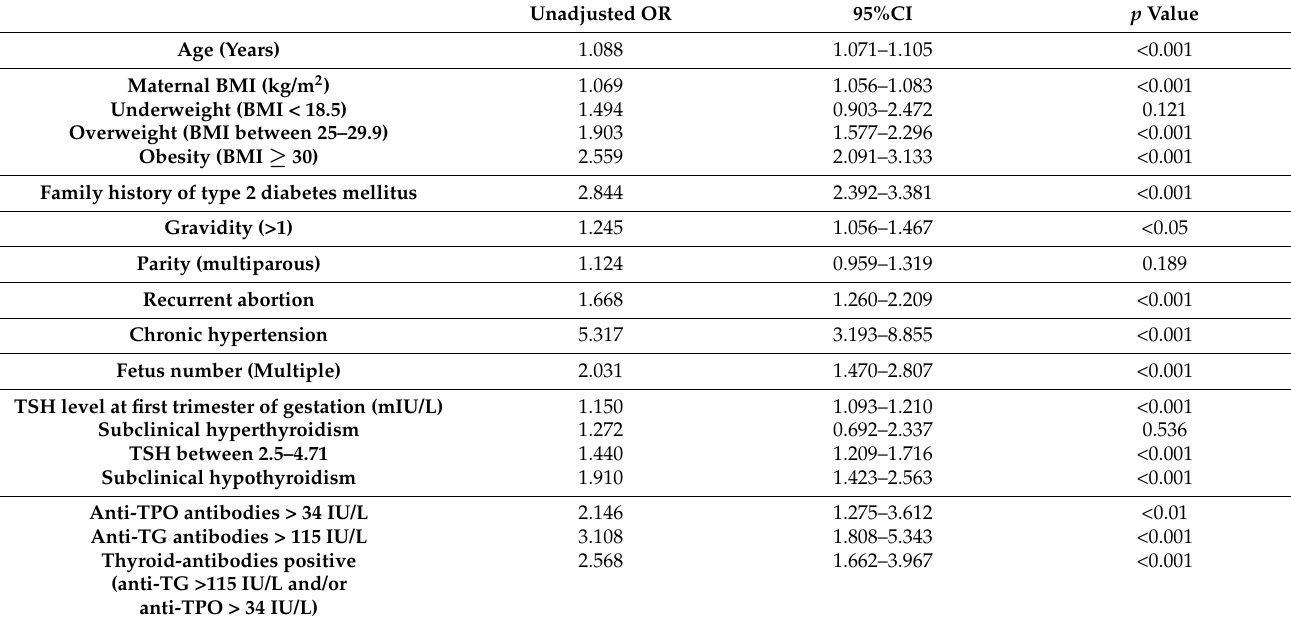
Table 2. Risk of gestational diabetes mellitus (bivariate